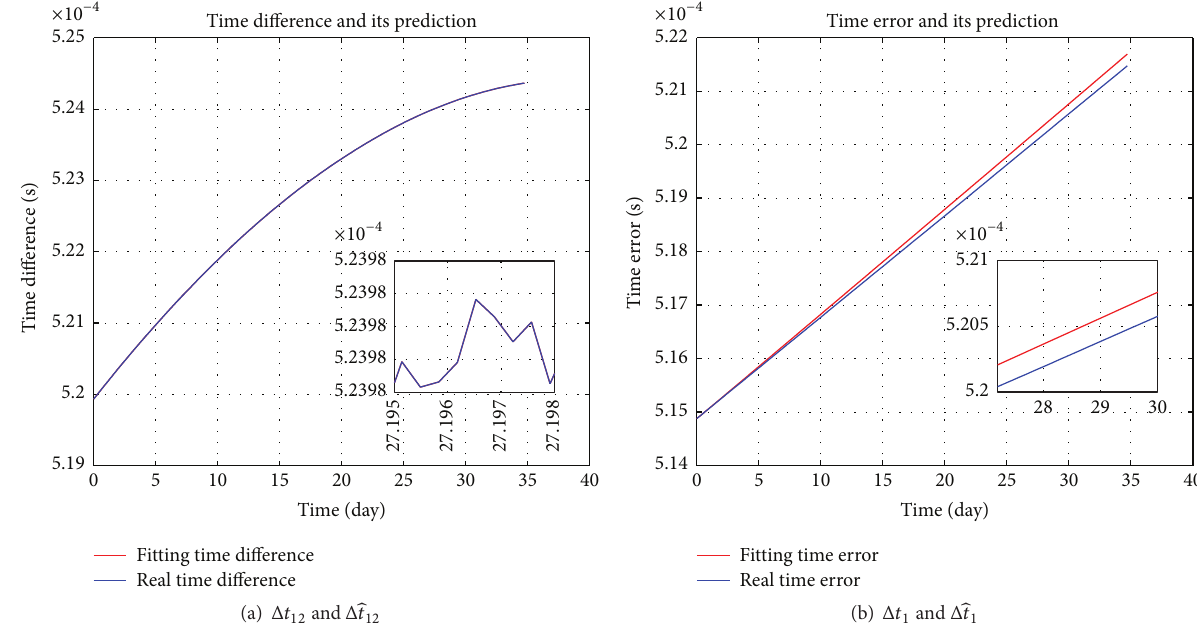
Figure 15: Prediction performance of Kalman filter for Δ𝑡 1 and Δ𝑡 12 .